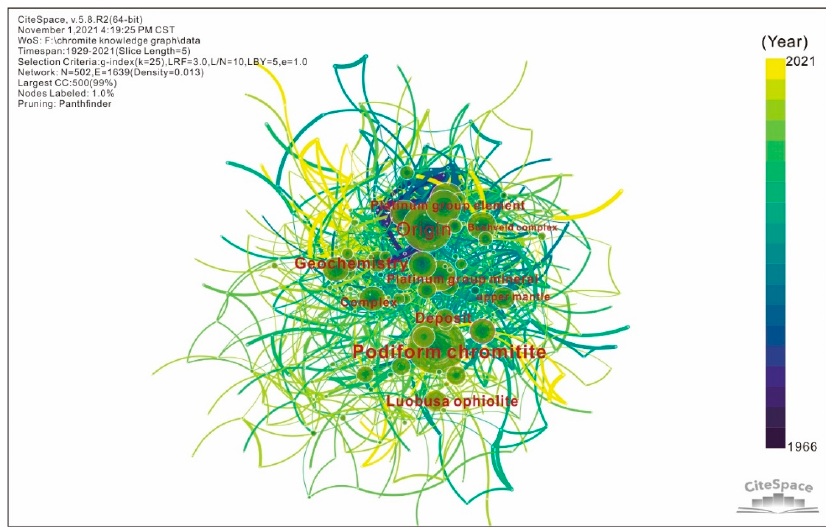
Figure 6. Co-occurring keywords